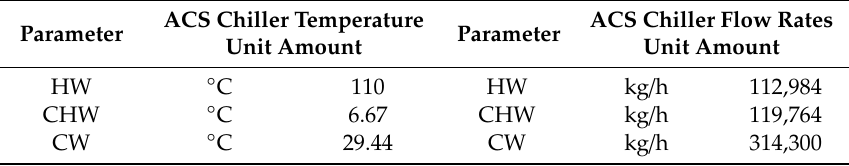
Table 1. Building envelop characteristics and design cooling load conditions.